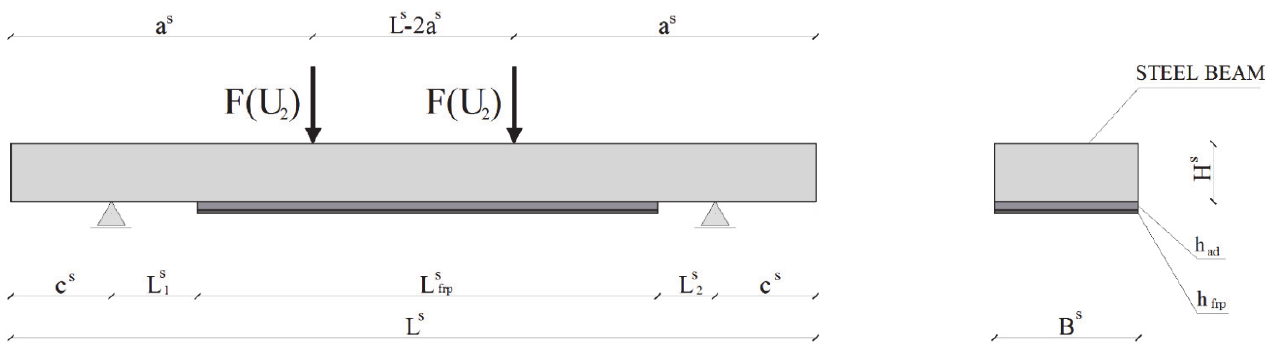
Figure 6: Steel beam configuration and loading